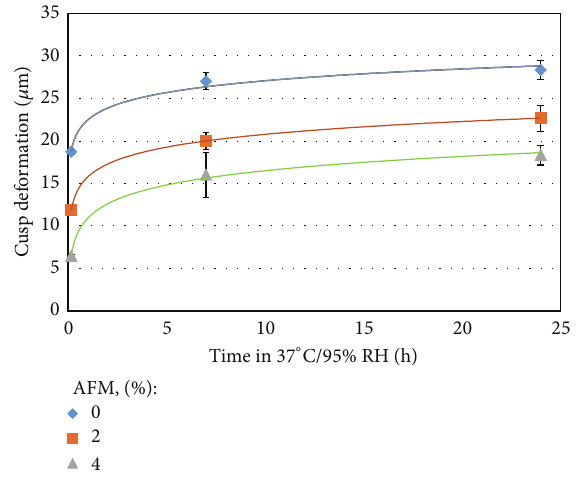
Figure 5: Change of cuspal deformation of Al blocks measured by micrometer as a function of postcure time and stress-relieving component (AFM) content in the final mix.